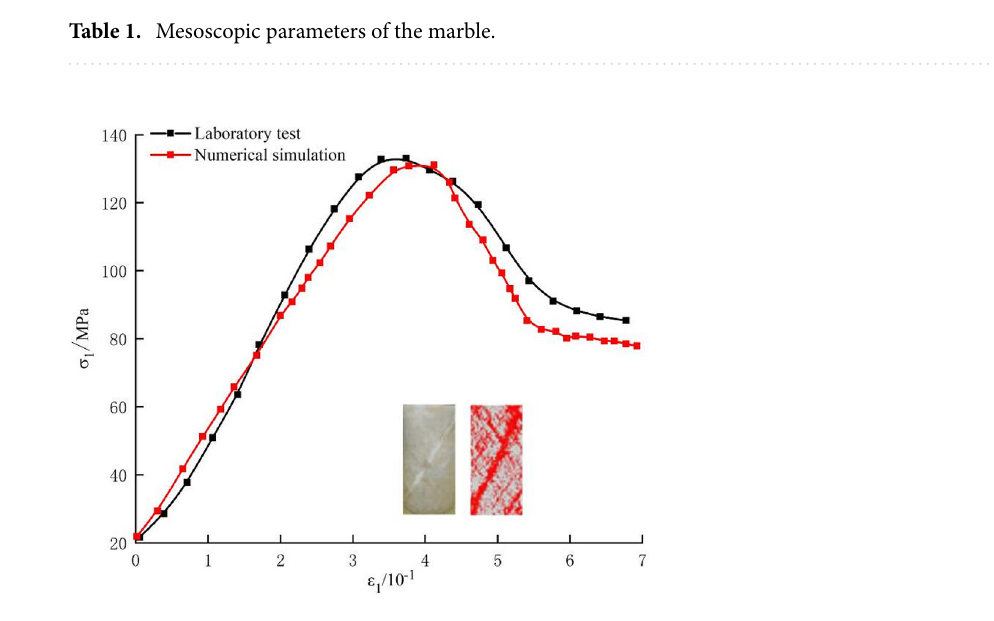
Figure 5. Comparison with the stress–strain curve and failure modes in the conventional triaxial test.